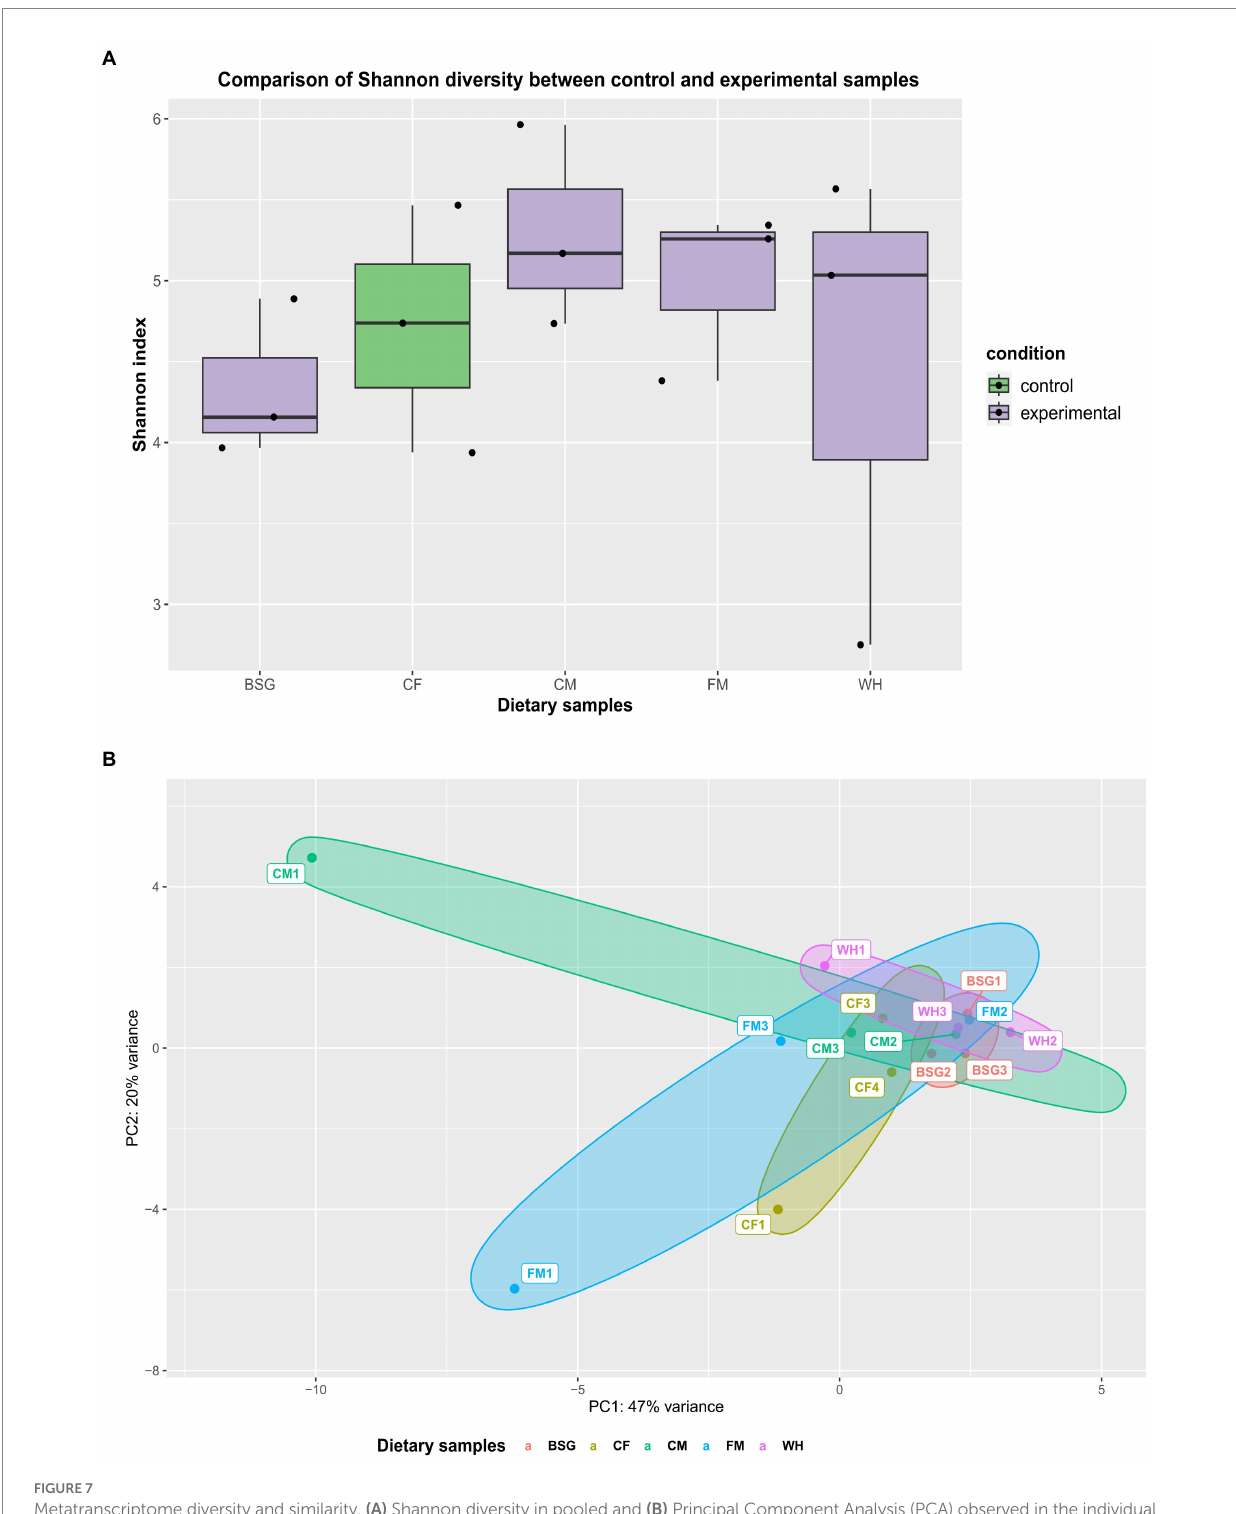
FIGURE 7 Metatranscriptome diversity and similarity. (A) Shannon diversity in pooled and (B) Principal Component Analysis (PCA) observed in the individual metatranscriptomes – chicken feed ( CF ), feed mix (FM), chicken manure (CM), brewer’s spent grain (BSG), and water hyacinth